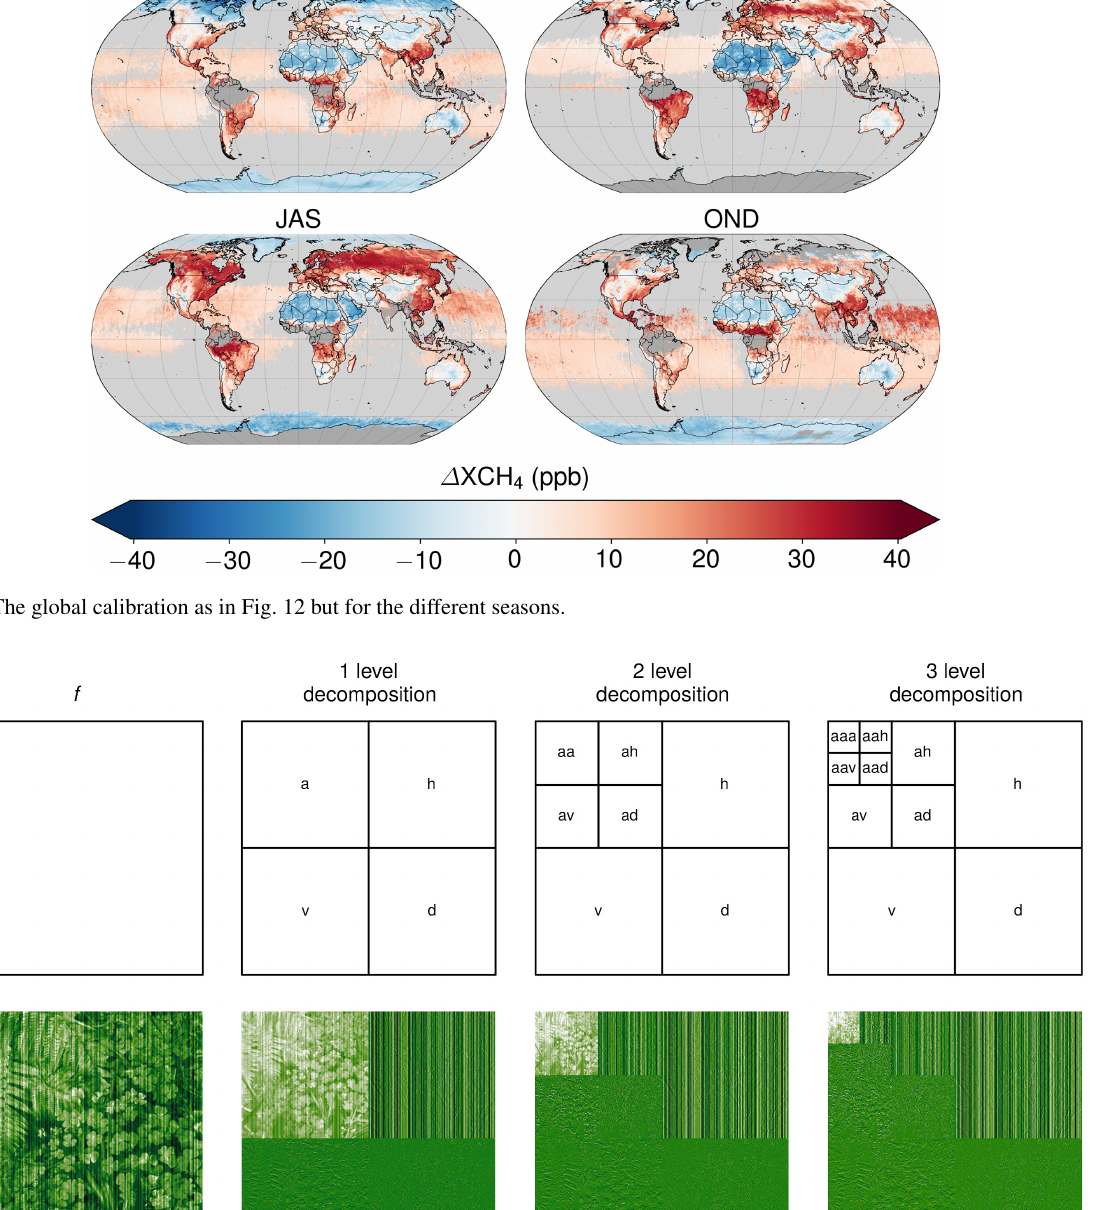
product version for both XCH 4 and XCO. For